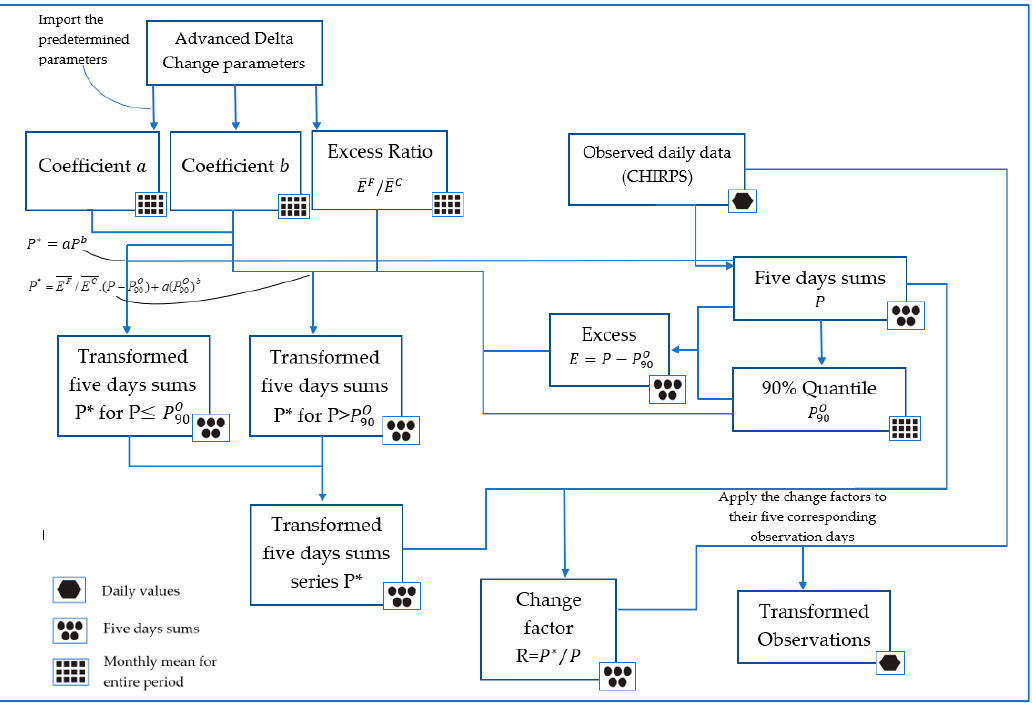
Figure 6. Flowchart of the transformation of the observation time series, or application of the coefficients (adapted from [42]).